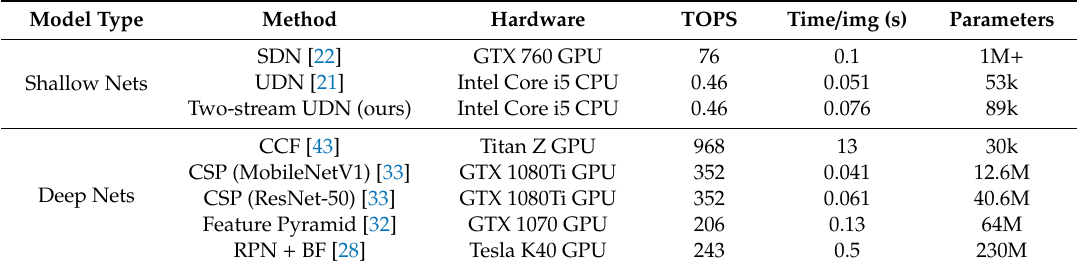
Table 4. Comparisons of running time among the state-of-the-art